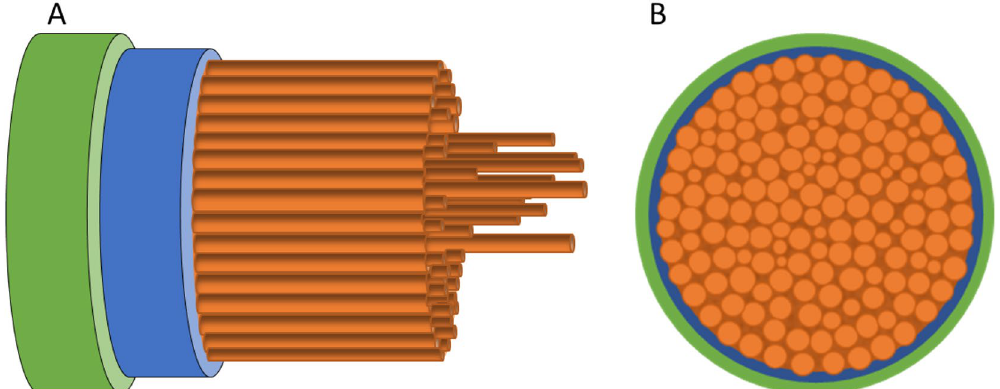
Figure 6. Schematic representation (not to scale) of the proposed structure of a spider silk fibre as found in the present work. ( A ) Fibre side view, ( B ) cross section through fibre. An outer, non-conductive lipid rich layer (green) of between 0.6 to 1 µm thickness, two conductive, inner autofluorescent protein layers: one which FITC shows higher affinity towards (blue), and another Rhodamine B shows a higher affinity towards (orange). The inner protein core consists of crystalline fibrils, aligned parallel to the long axis of the fibre, surrounded by more amorphous protein